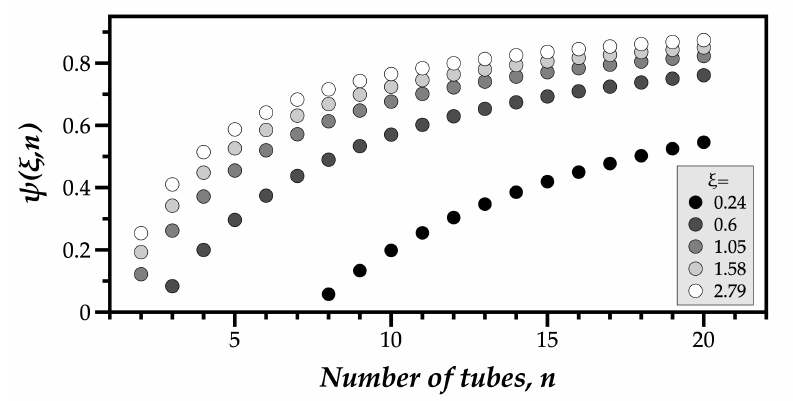
Figure 11. Effect of the number of